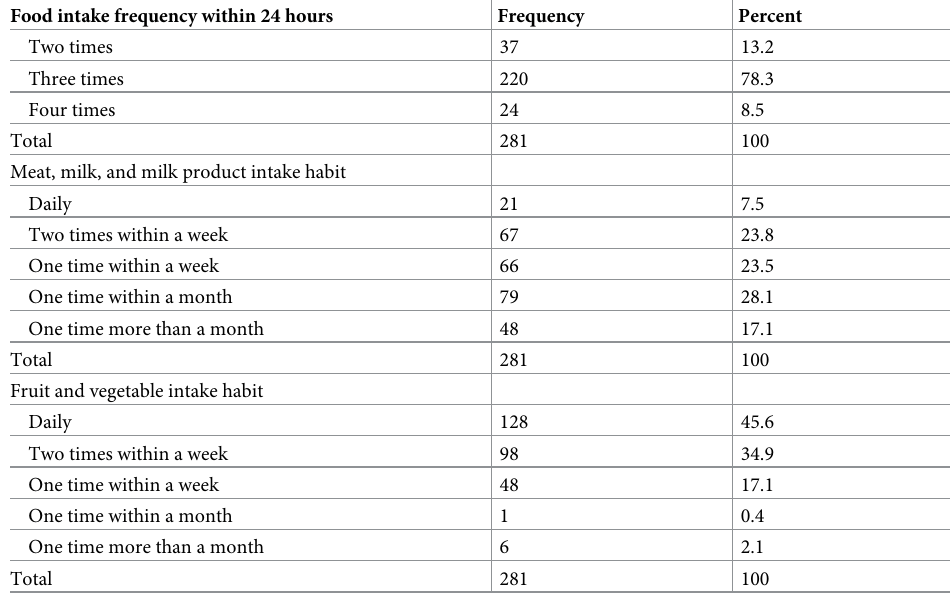
indicating good nutritional status. The mean, median and interquartile range of MUAC was 25.7 cm, 25 cm, and 27.75 ± 7.75 cm, respectively (Table 3). Prevalence of intestinal parasites among pregnant women Among 281 first-trimester pregnant women, 94(33.5%) were infected by at least one intestinal parasite. Among detected intestinal parasites hookworm dominated prevalence with a rate of Table 2. Dietary characteristics of pregnant women attending antenatal care at Debre Markos Referral Hospital,